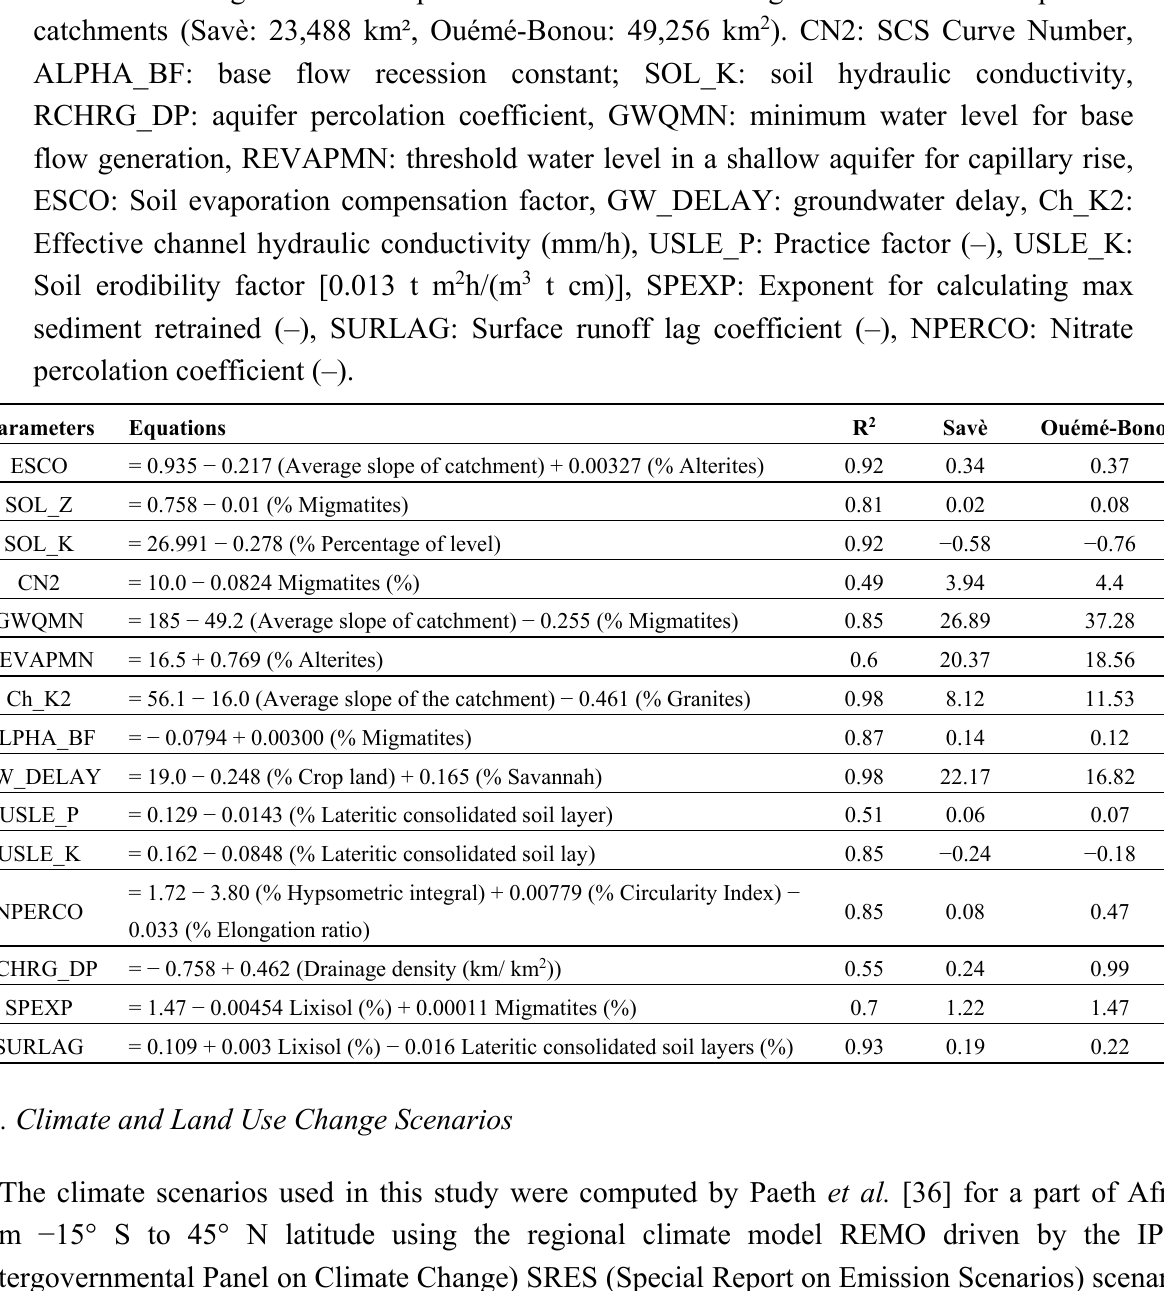
Table 5. Best regression-based parameter model and resulting values for three independent catchments (Savè: 23,488 km², Ouémé-Bonou: 49,256 km 2 ). CN2: SCS Curve Number, ALPHA_BF: base flow recession constant; SOL_K: soil hydraulic